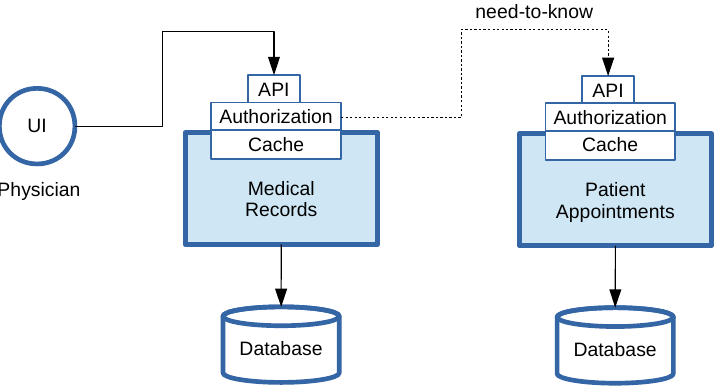
Figure 10. Policy evaluation depending on third party